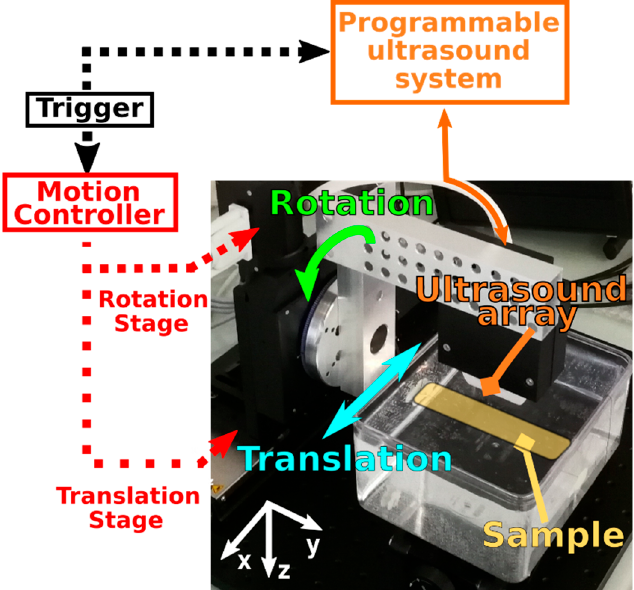
Figure 3. Annotated picture of the experimental setup. The rotate-translate scanner is comprised of two motorized stages that scan an ultrasound (US) array. The rotation stage is mounted on the translate stage. The US array is fixed on the rotation stage with a custom-built holder. The array axis (axis along the row of its elements) was manually aligned to correspond to the rotation axis. Triggers synchronize (1) recording the motion-controlled stage positions and (2) the US acquisition with the programmable US system. The imaged sample is placed in the water tank below the array. The axes of the fixed-coordinate system ( e x , e y , e z ) are represented. For the sake of readability, only the subscripts x, y, and z are reported in the diagram. The y-axis and the z-axis correspond to the rotation axis and the radial direction when α rot = 0, respectively. Due to possible experimental misalignment, the translation axis is assumed to be close to the x-axis but may not exactly match. The scanner in action is shown in Video S1.